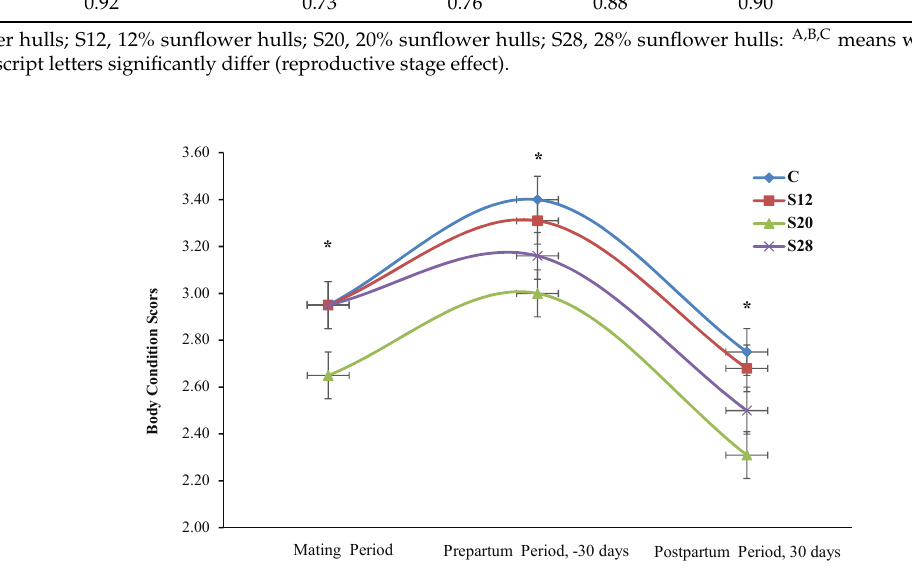
Figure 1. The effects of different levels of sunflower hulls in total mixed ration on body condition score (1–5) during late different reproductive stages. * period effect ( p < 0.001).